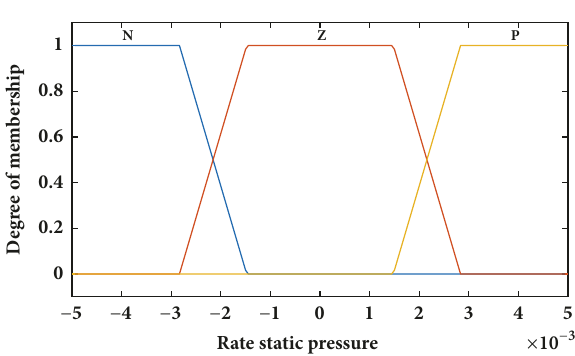
Figure 13: MFs of change in Δ P s .